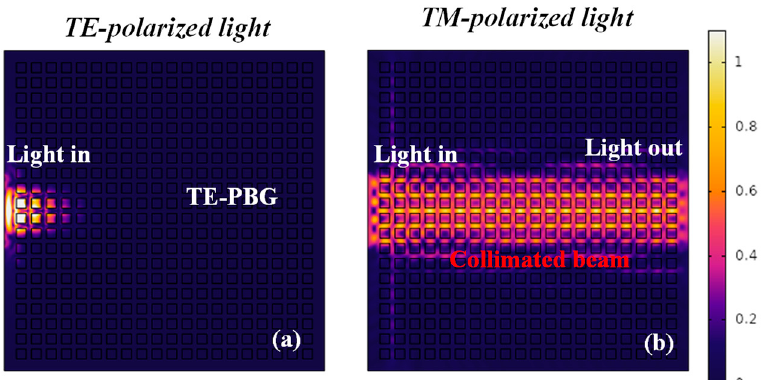
Figure 4. Norm. E-field mapping at λ = 1550 nm at ( a ) TE-polarization of light, ( b ) TM-polarization of light.